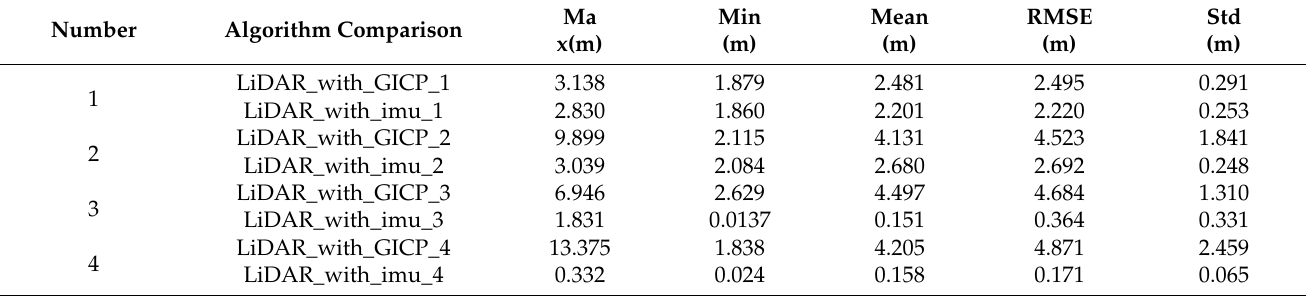
Table 3. Comparison of relative error of